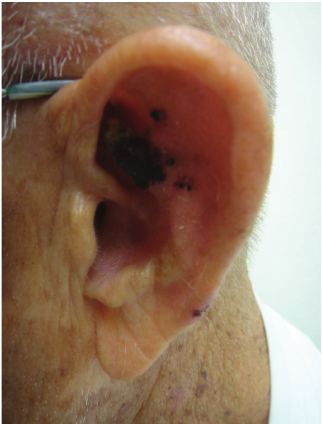
Figure 1: The preoperative photo of the left ear with squamous cell carcinoma on the antihelix.